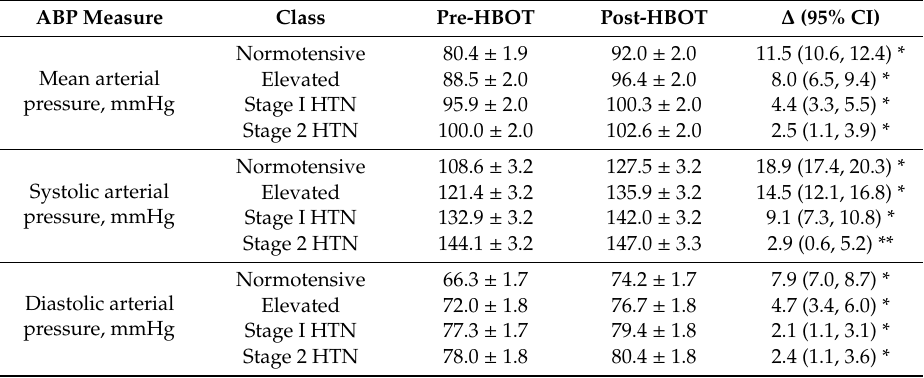
Table 5. Arterial blood pressure changes before and after HBOT in patients stratified by hypertension classification based on baseline arterial blood